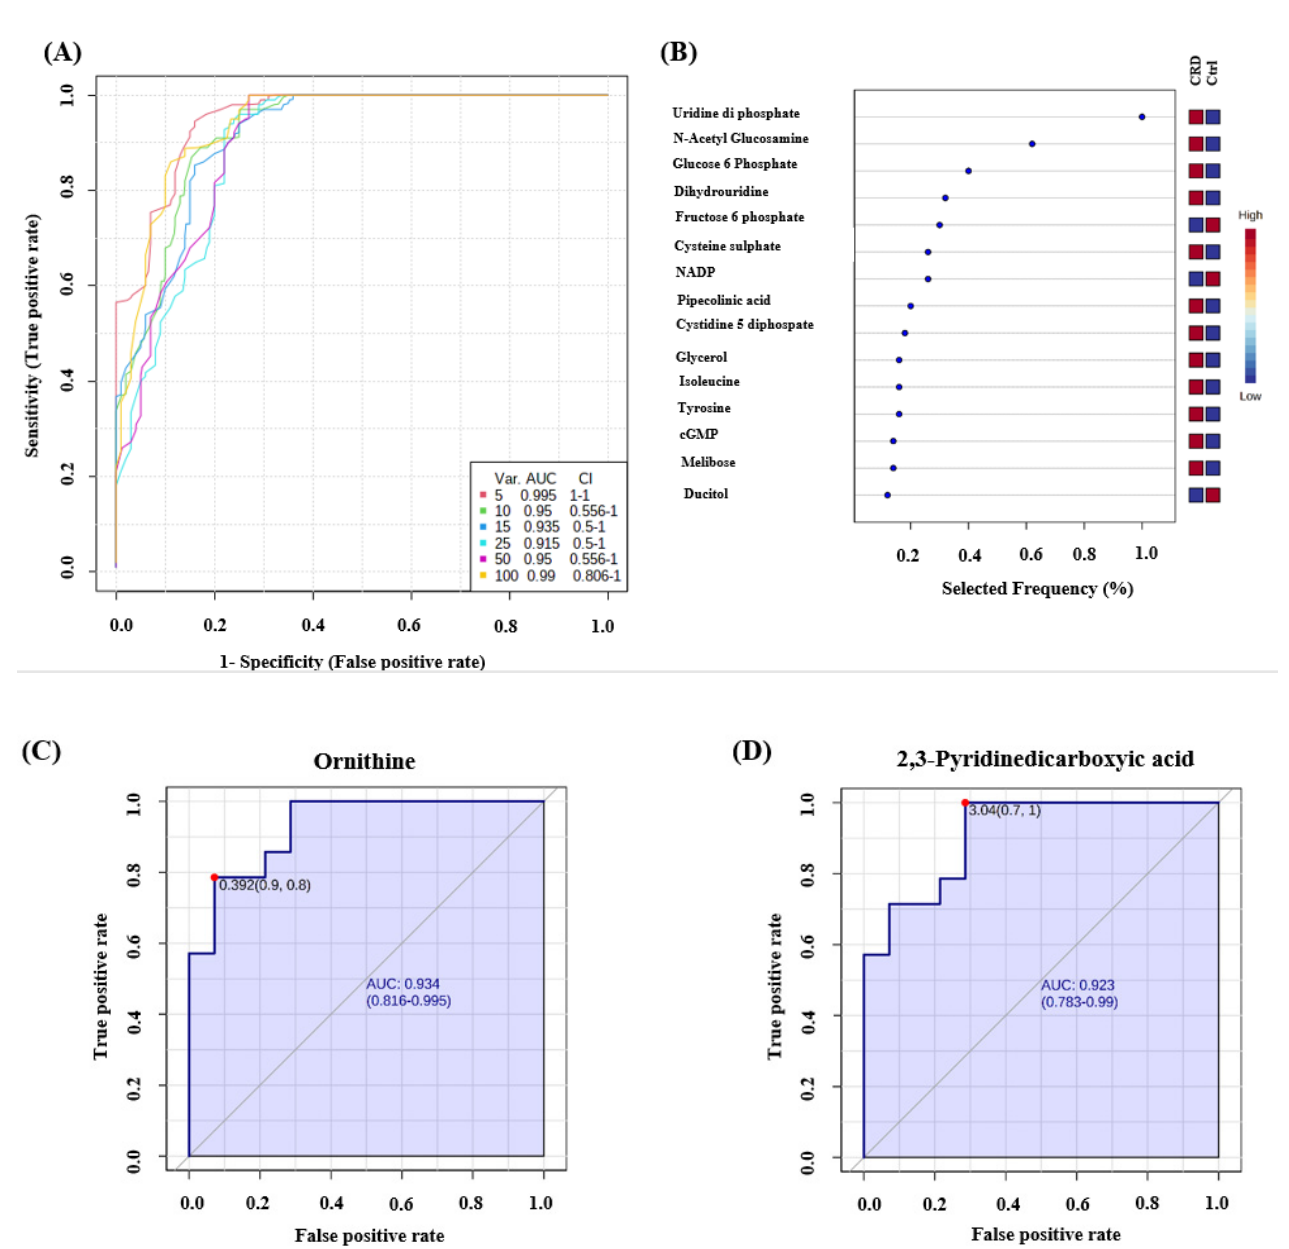
Figure 4. Receiver operating characteristics (ROC) curve and loading plots for significant metabolites in DBS of patients with cystic renal diseases. ( A ) ROC was generated by PLS-DA model showing area under the curve (AUC) for the top five variants = 0.995. ( B ) Frequency percentage plot of the dysregulated metabolites in CRD patients when compared to the controls. ( C ) Ornithine (AUC-0.934) and ( D ) 2,3-Pyridinedicarboxyic acid (AUC-0.923) were down regulated in CRD patients Data were normalized, transformed, and scaled by median, log, and Pareto scaling to make sure all the data are under Gaussian distribution.